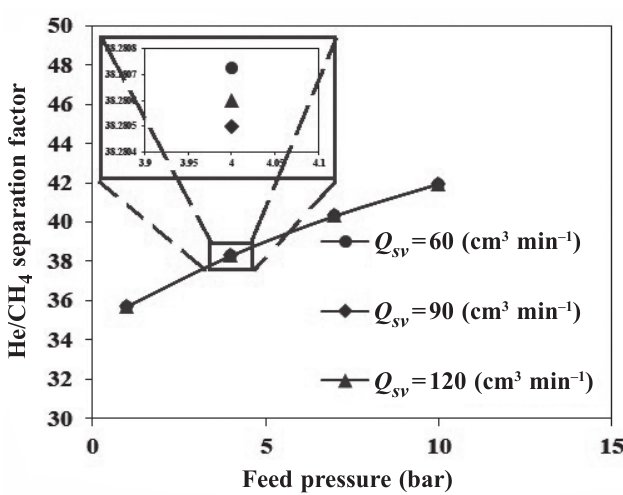
Fig. 5 – Impact of feed pressure on He/CH separation factor 4 at a different feed flow rate mole fraction of gas components on both sides of the membrane ( y and x are mole fraction in perme- ate and feed side of the membrane,